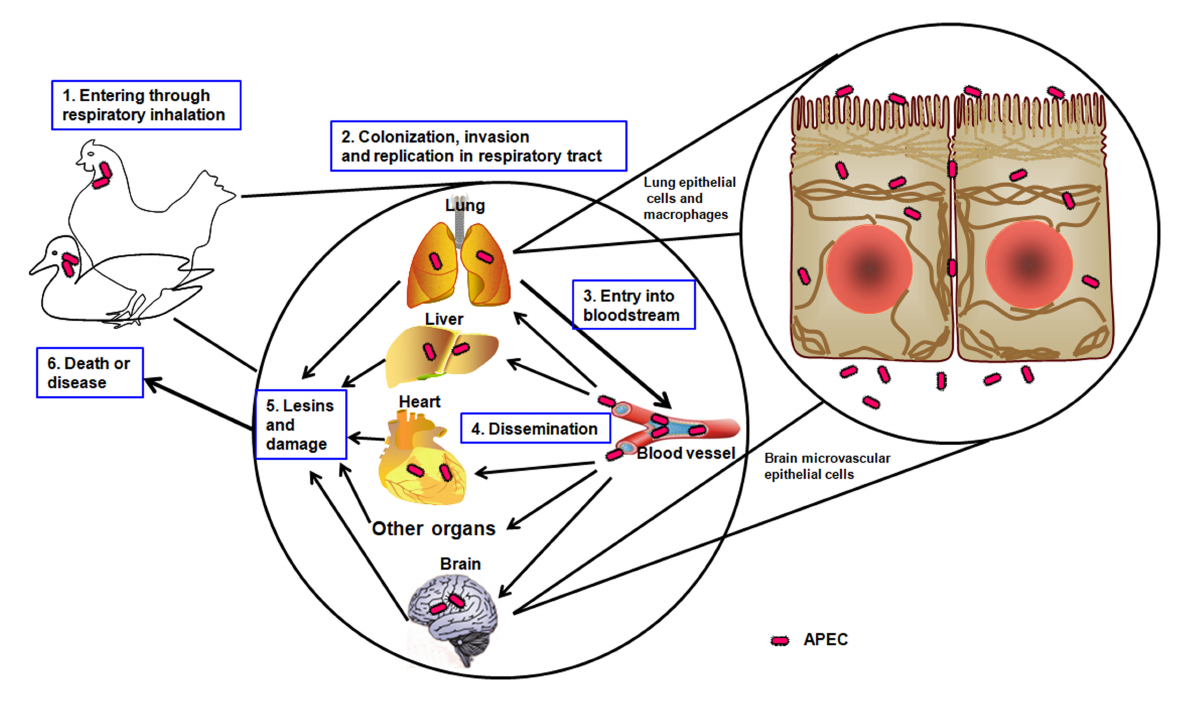
FIGURE1 The pathogenic mechanism of APEC. The schematic illustrates the APEC infection progress in avians, such as chickens or ducks.